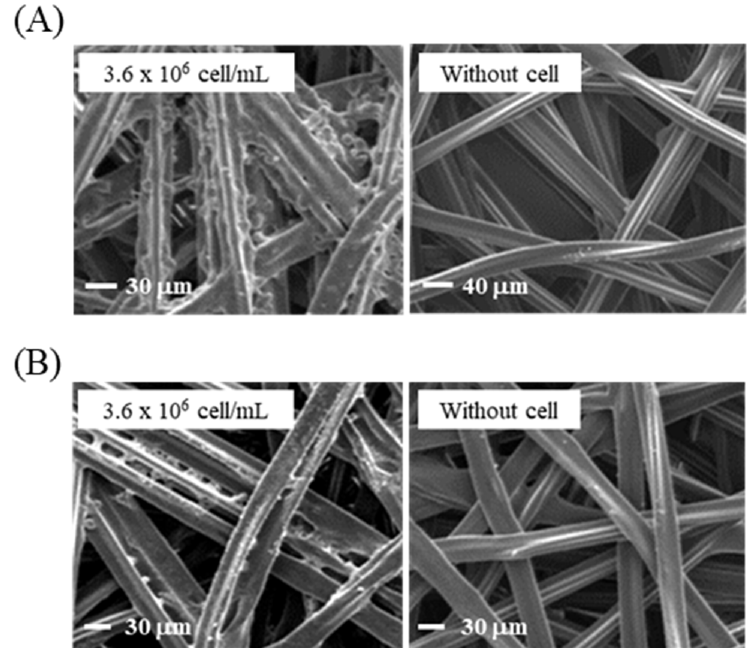
Figure 4. Morphological patterns of immobilized cells on the membrane scaffolds. FE-SEM images were obtained for ( A ) hydrophobic and ( B ) hydrophilic matrices, respectively, immobilized to cell concentrations of 3.6 × 10 6 cells/mL. The cell densities of the solid matrices were compared to those of bare membranes (without cells).